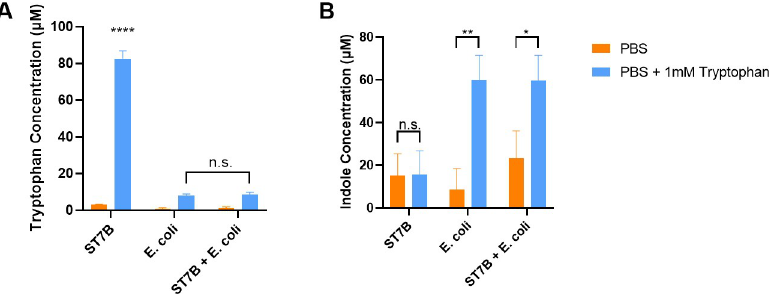
Fig 7. Blastocystis ST7-B does not convert tryptophan to indole readily. A) Graph of tryptophan concentration post-24-hour incubation period when culturing Blastocystis and E . coli in PBS supplemented with tryptophan. B) Graph of indole concentration in the same cultures. Significance levels were calculated using a two-way ANOVA, with � = p < 0.05, �� = p < 0.01, and ���� = p < 0.0001. N = 3 for all columns.